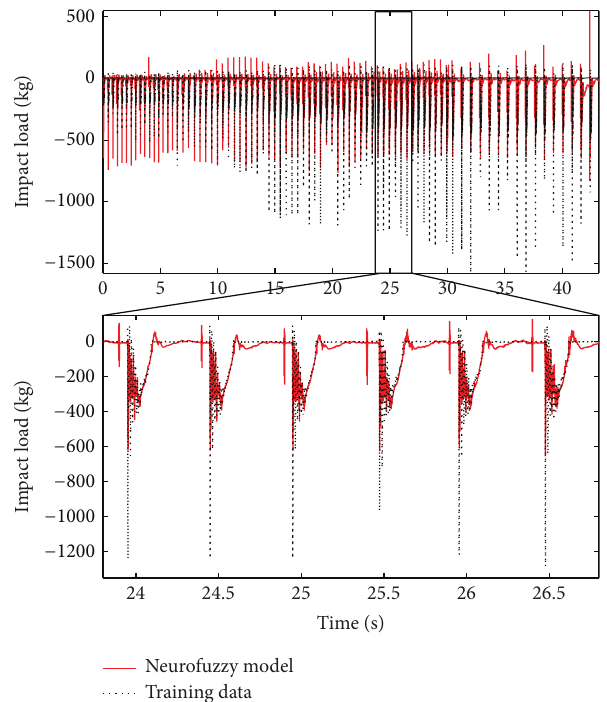
Figure 15: Neurofuzzy training results: constant, sinusoidal, and random currents for different drop release heights.